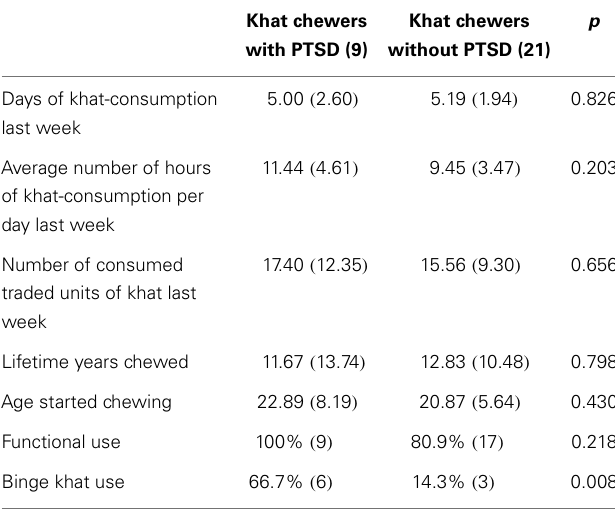
Table 4 | Khat-use patterns in chewers with and without PTSD